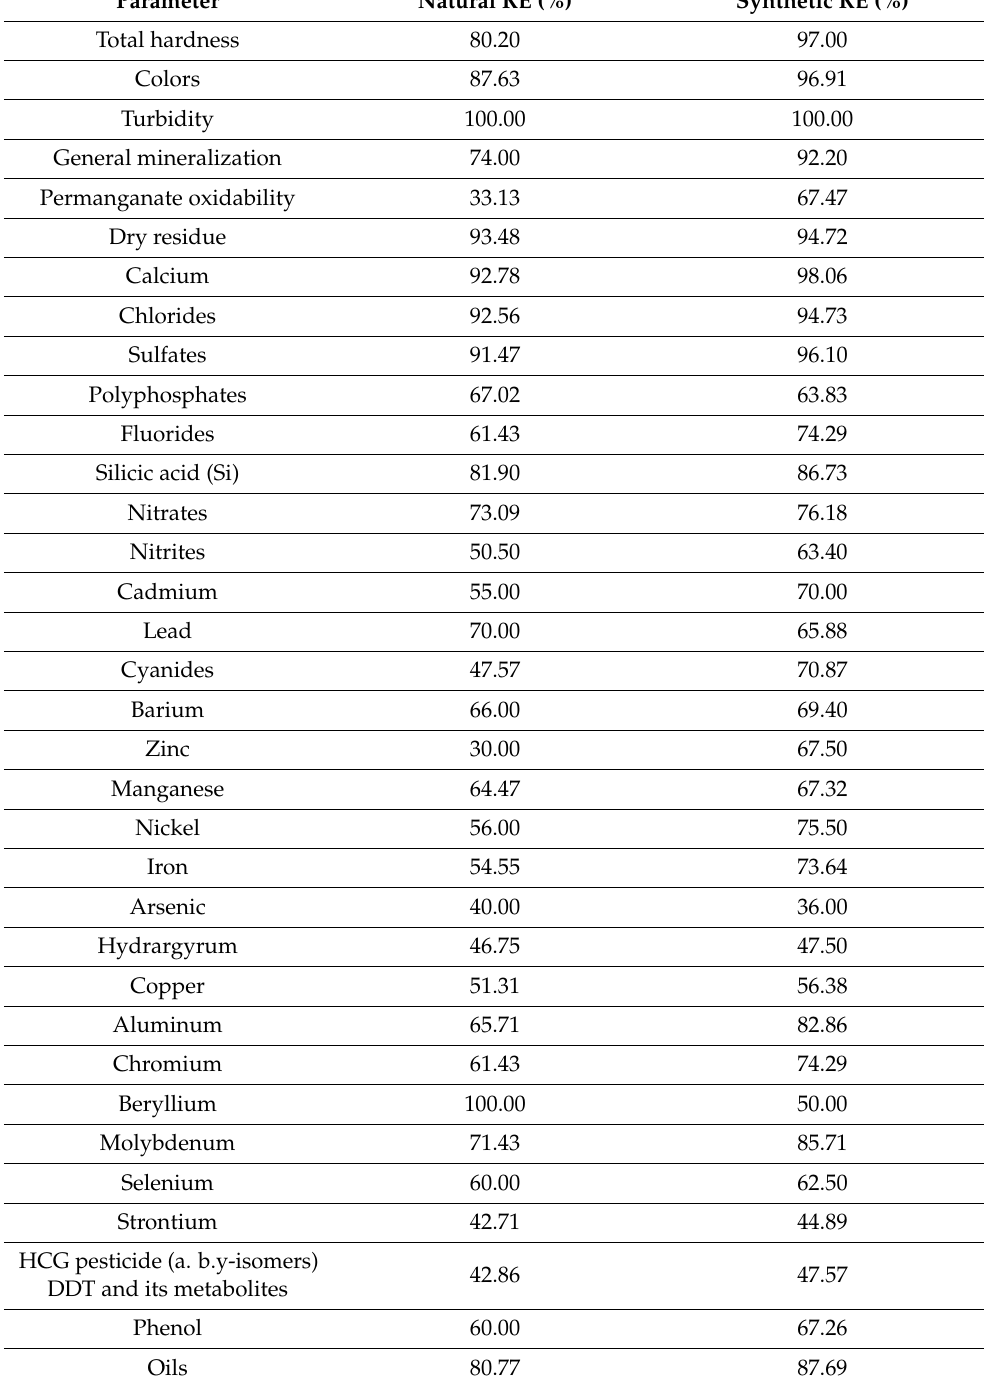
Table 6. Removal efficiency of natural and synthetic